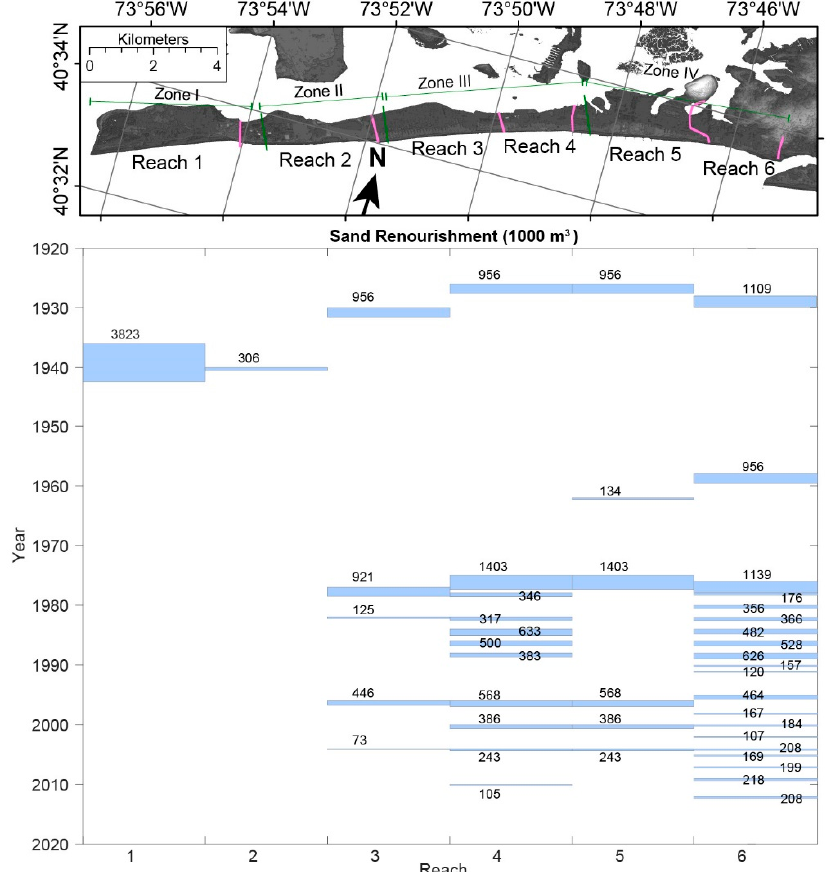
Figure 3. The volume and relative location of sand renourishment at the Rockaway Peninsula from 1920 through 2020. Blue bars indicate a renourishment event and are centered on the year during which they occurred. The widths of blue bars are proportional to their volume, which are labeled. Data for renourishment volumes are from U.S. Army Corps of Engineers (USACE) [46]. As the USACE data describe relative location by 6 reaches, the locations of these reaches are shown by pink vertical lines on the map. North of the peninsula, green bars and lines indicate the extent of geomorphic zones from this study.